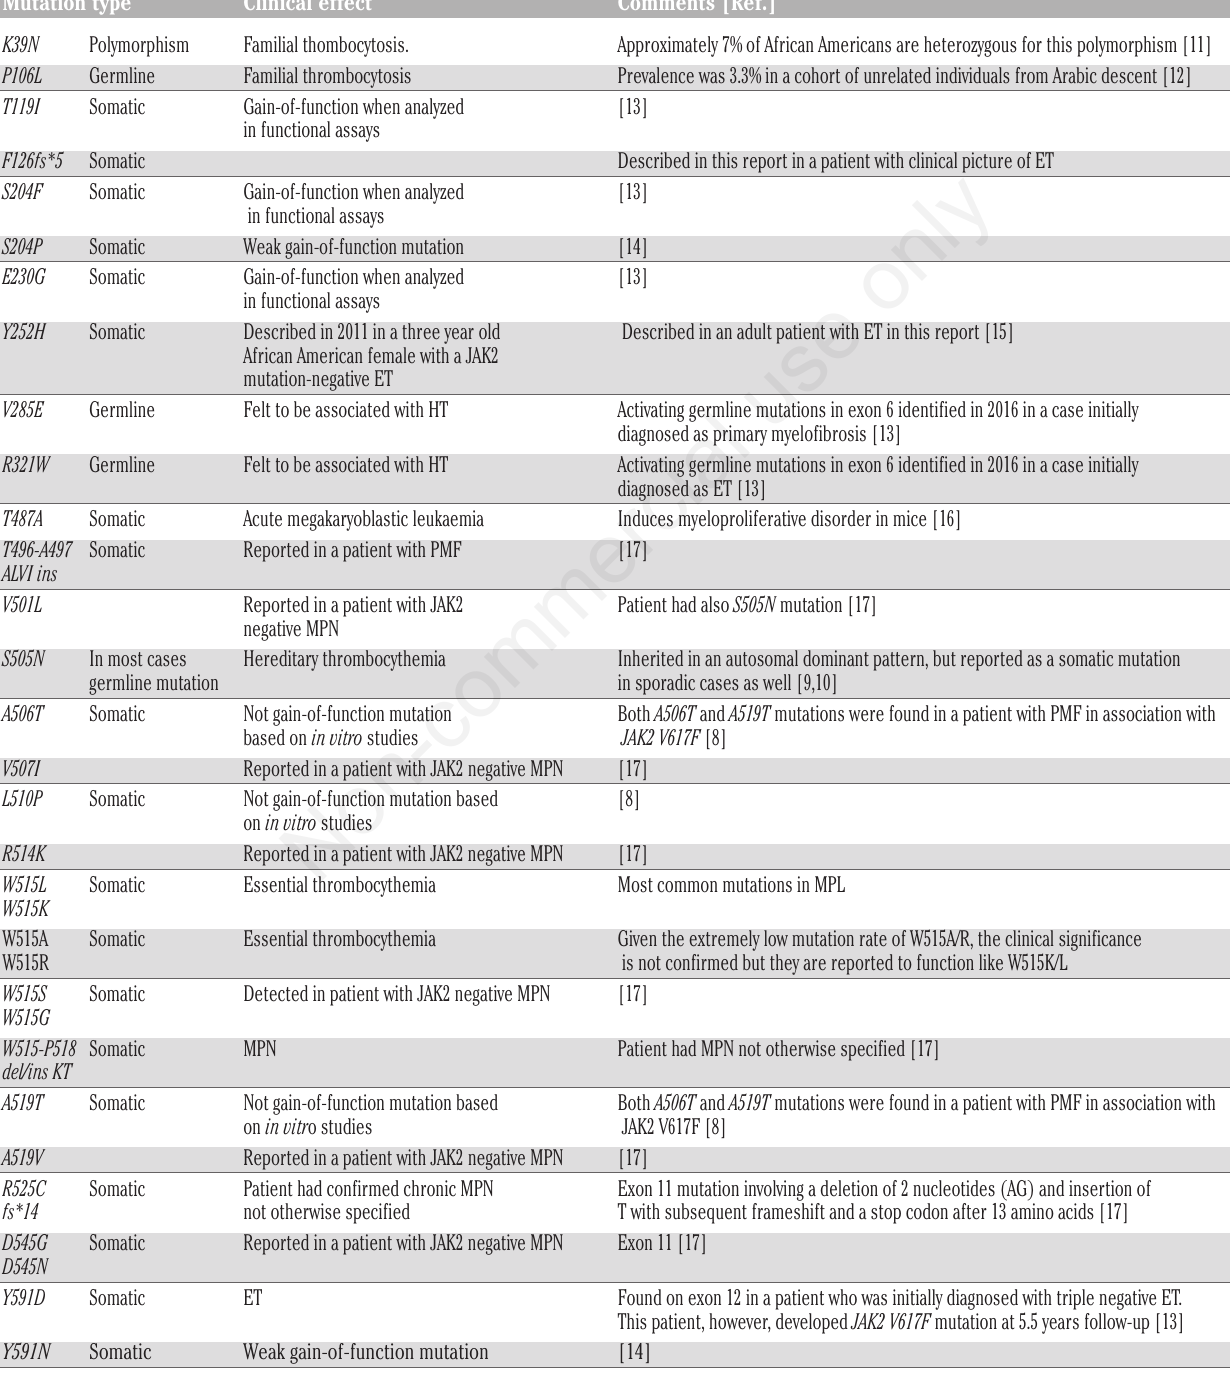
Table 1. Mutations reported in MPL